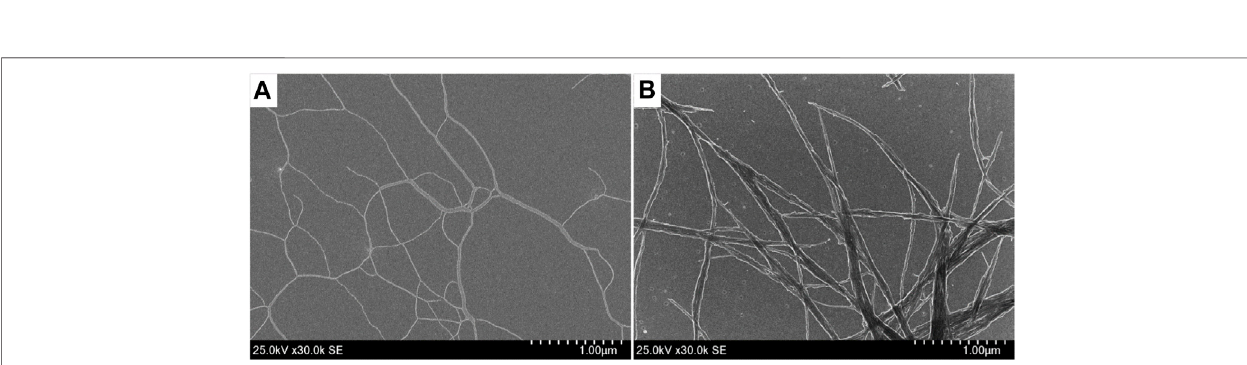
Frontiers in Chemistry |